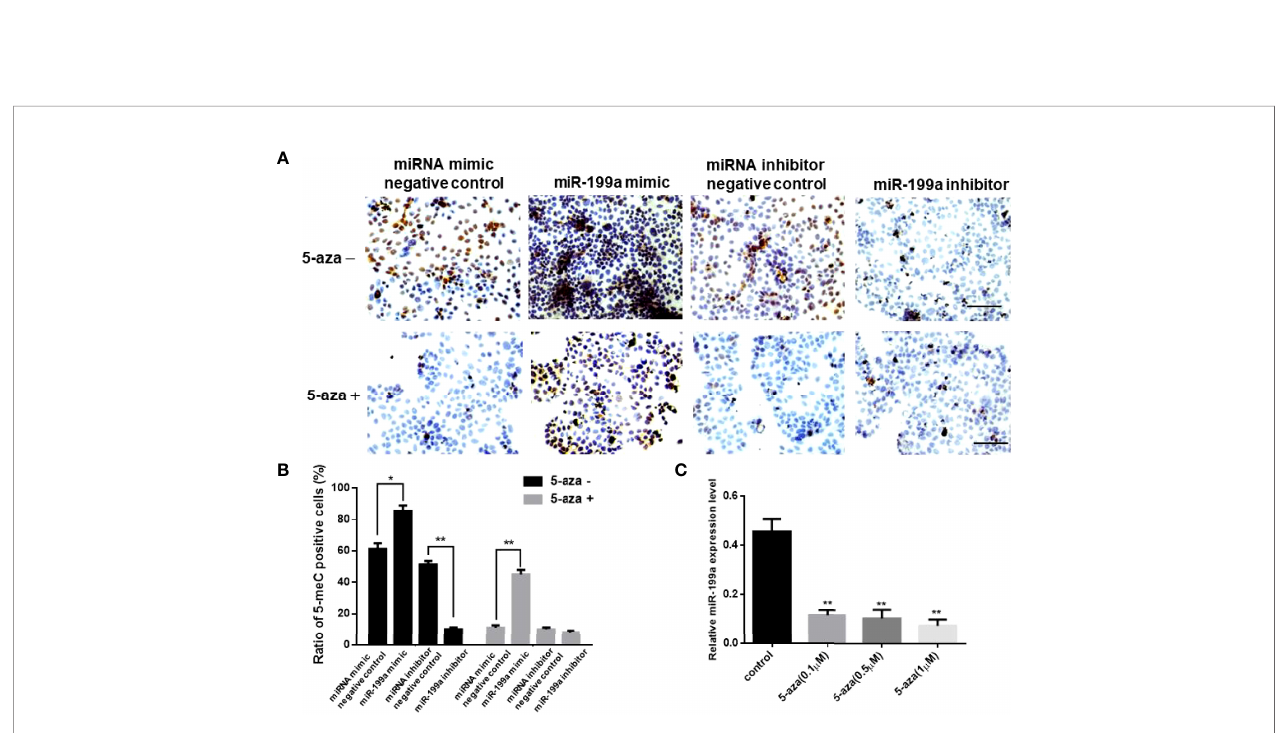
FIGURE 2 | miR-199a mimic upregulates cellular methylation levels. (A, B) 5-aza immunohistochemical detection of the effects of miR-199a mimic and miR-199a inhibitor on the overall methylation level of JEG-3 cells. Brown is a positive signal. n=3. (C) Real-time PCR detection of miR-199a expression in JEG-3 cells treated with different concentrations of 5-aza. n=3. The scale bar indicates a distance of 100 m m. * P <0.05; ** P